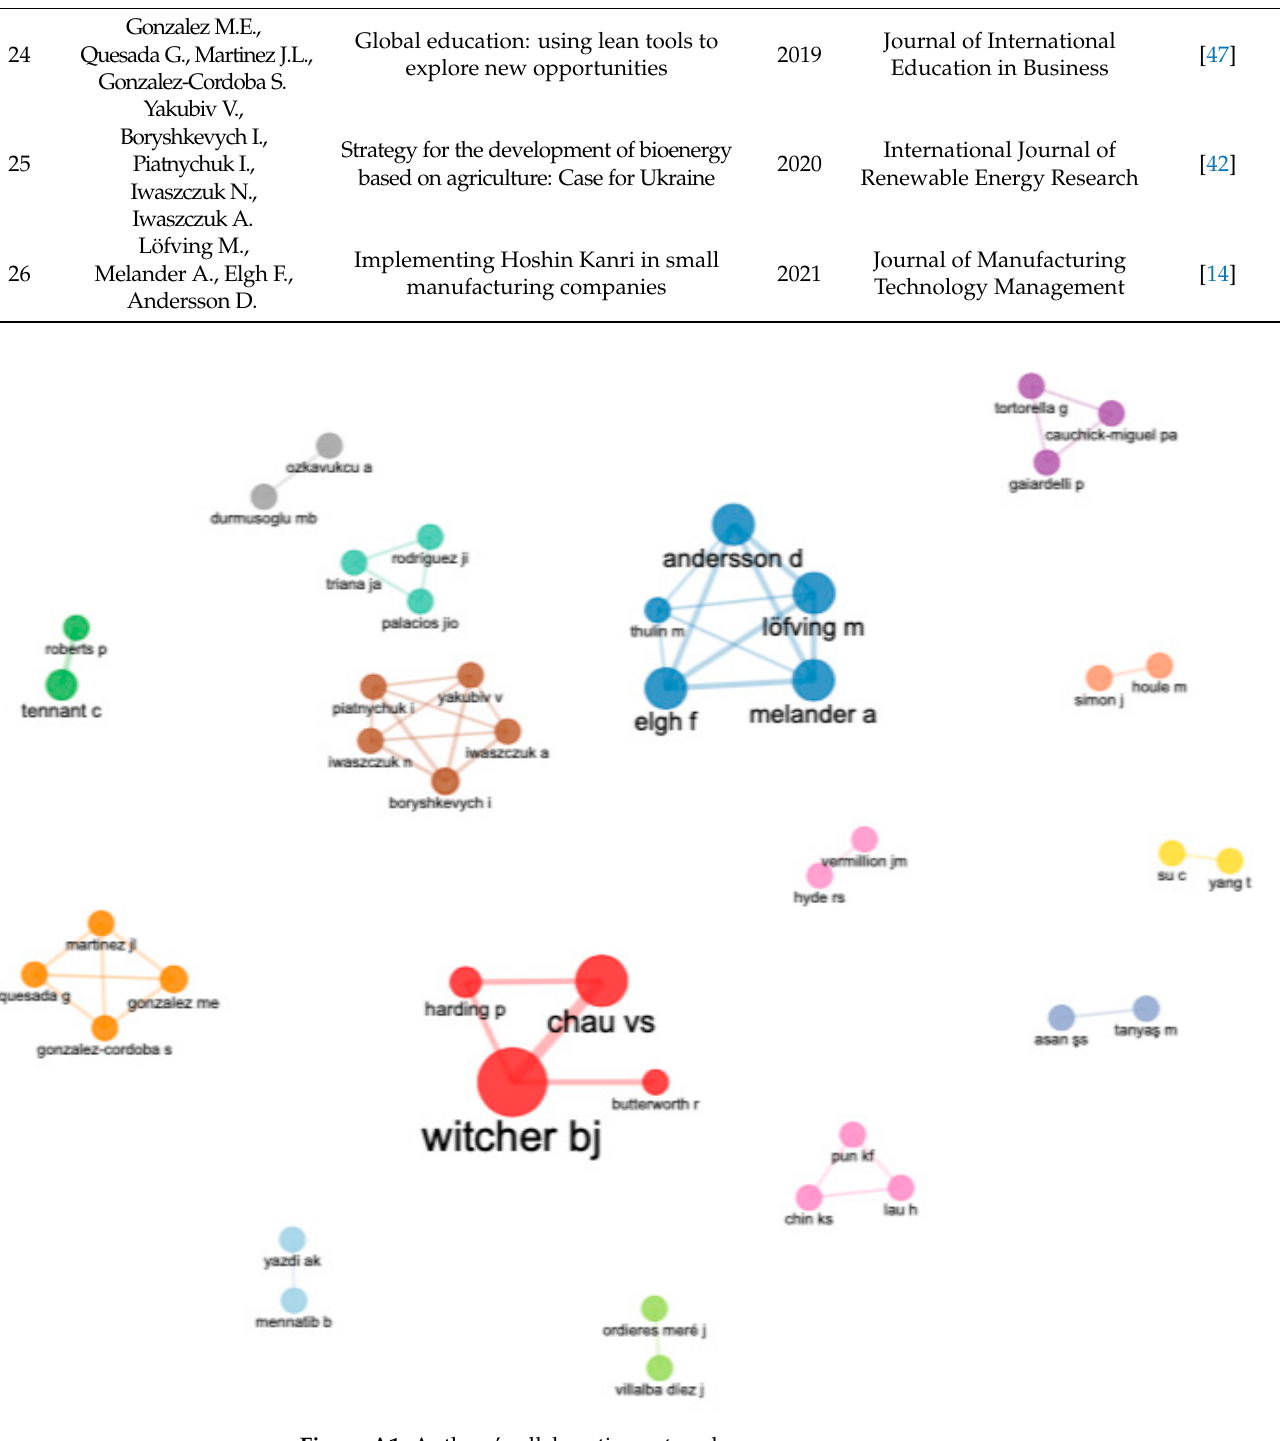
Figure A1. Authors’ collaborative network.